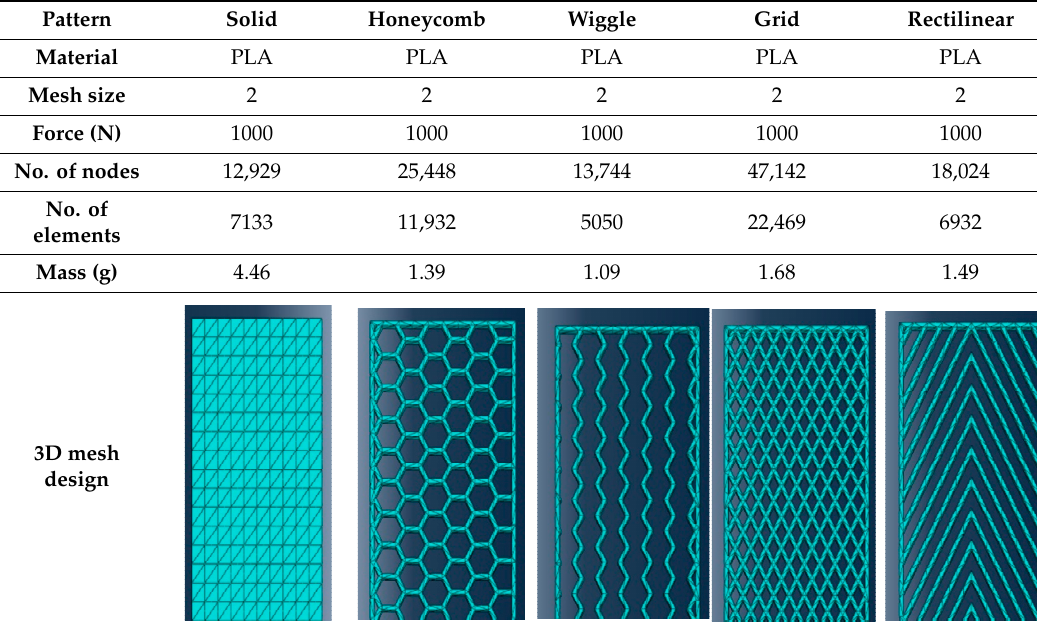
Table 1. Samples ′ features in FEA according to PLA material properties.